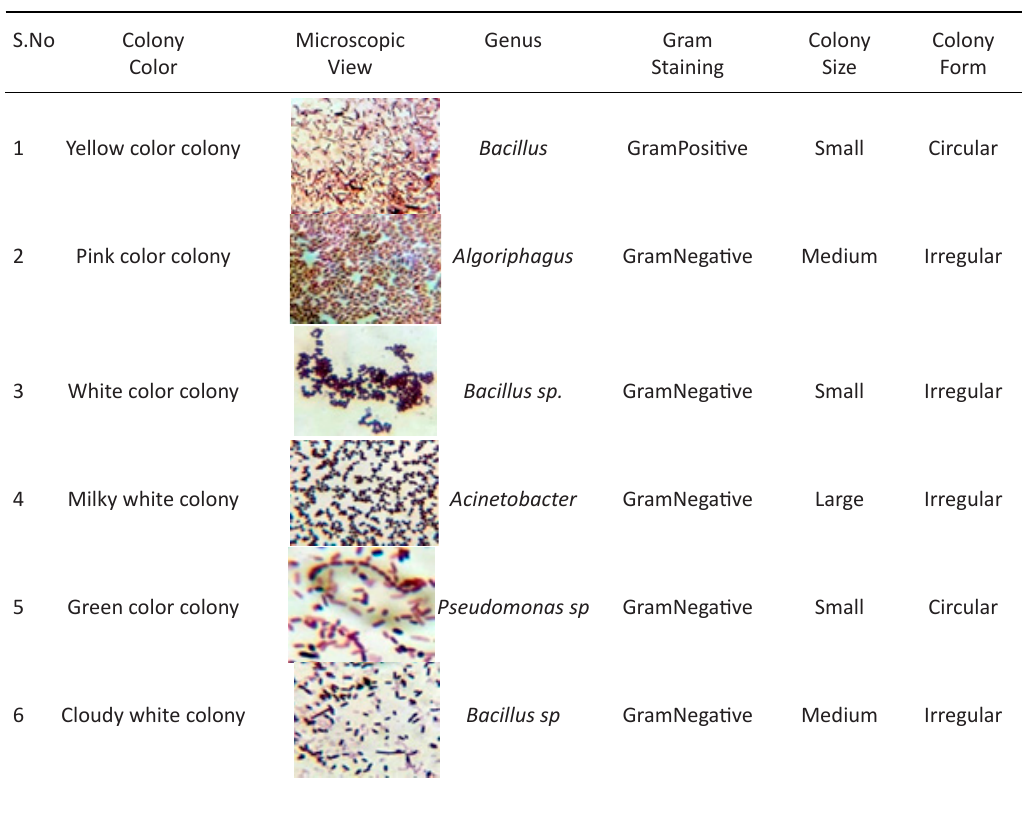
Table 2. Morphological characteristics of the bacterial isolates cultured on Nutrient agar medium